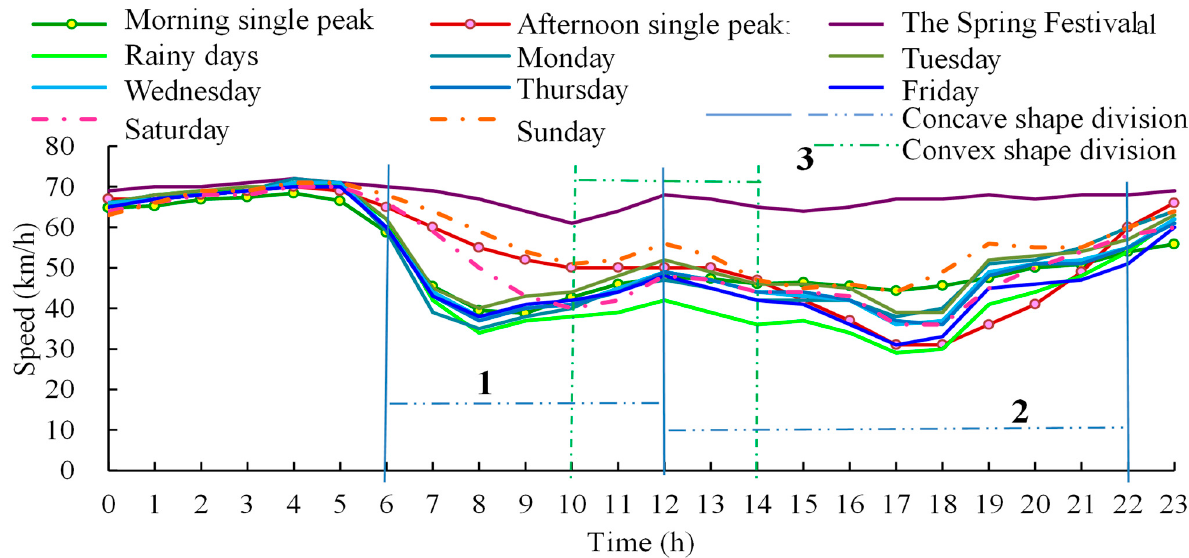
Figure 2. Geometric characteristics of traffic flow speed curves.